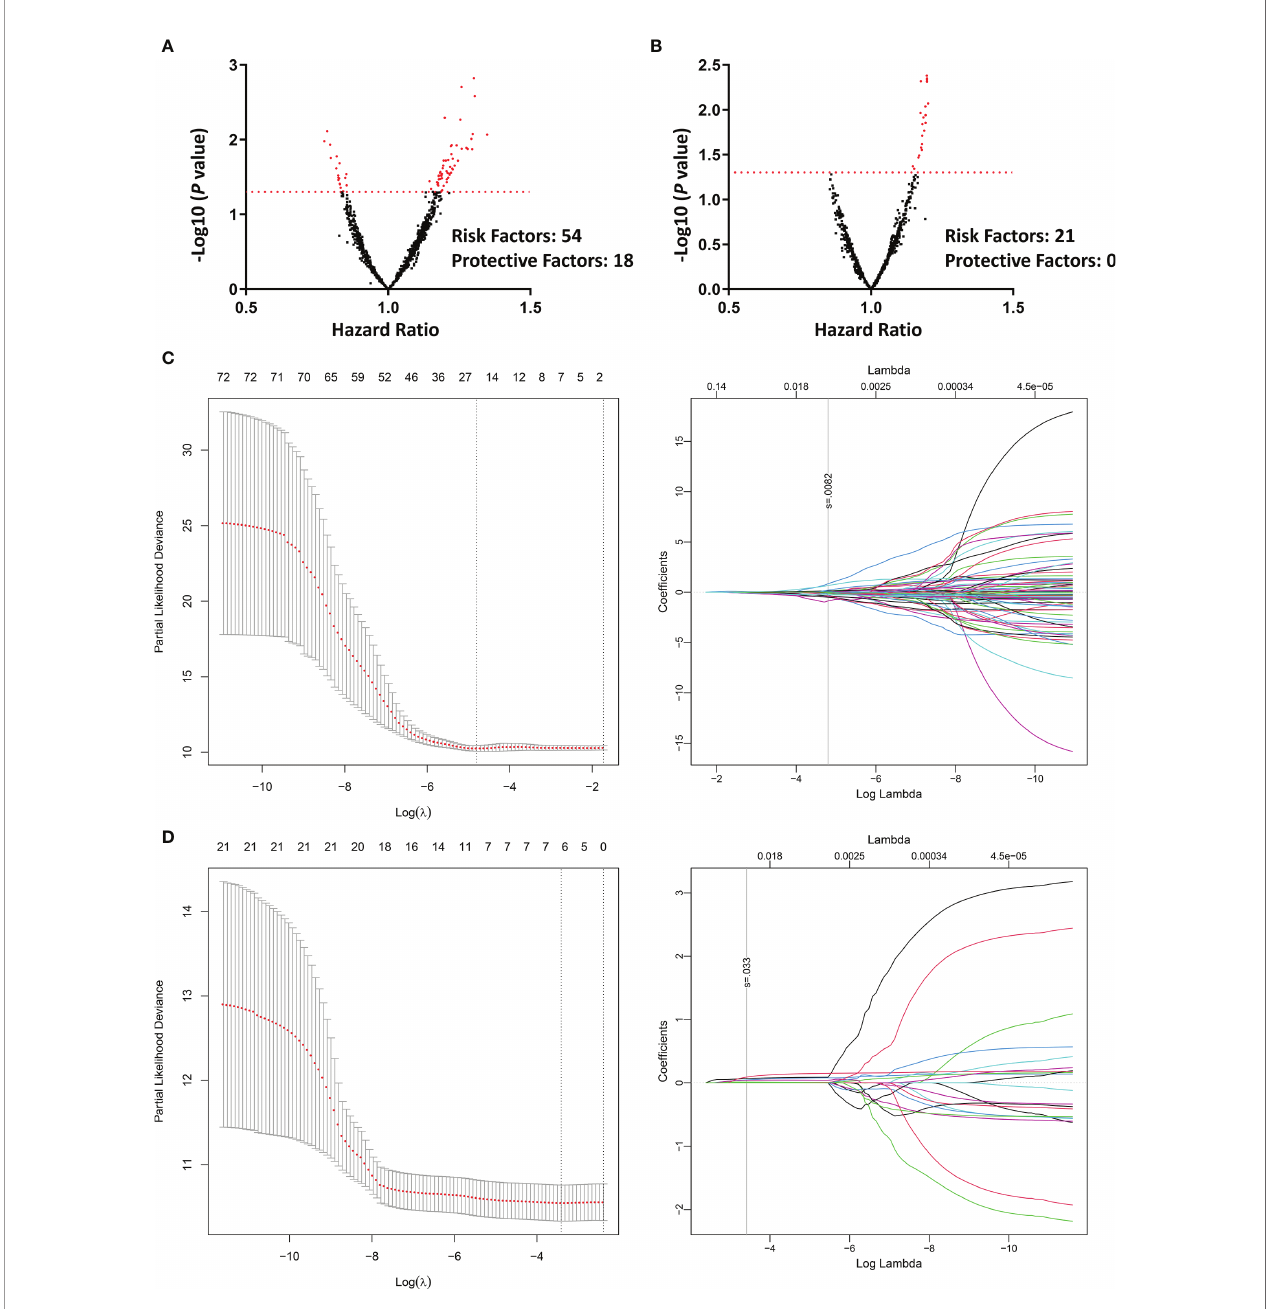
FIGURE 3 | Univariate COX regression and LASSO regression assessing the prognostic value of different radiomic features in predicting the ef fi cacy of second-line osimertinib therapy. (A, B) , Volcano plots re fl ecting each radiomic feature ’ s value in predicting PFS [ (A) , contrast-enhanced phase; (B) , unenhanced phase]; (C, D) , LASSO COX regression based on radiomics feature from the contrast-enhanced (C) and unenhanced (D) chest CT. PFS, Progression-free survival; LASSO, Least absolute shrinkage and selection